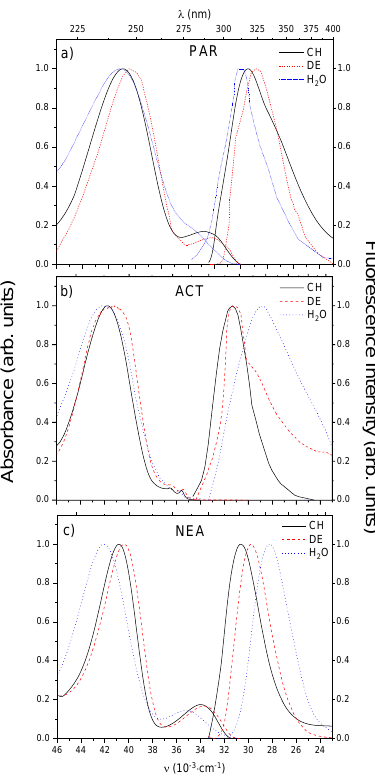
Figure 2. The long-wavelength absorption and fluorescence spectra of ( a ) PAR, ( b ) ACT and ( c ) NEA in solvents of different polarity: cyclohexane (CH, black straight line), diethyl ether (DE, red dashed line), and in deionized water (H 2 O, blue dotted line).